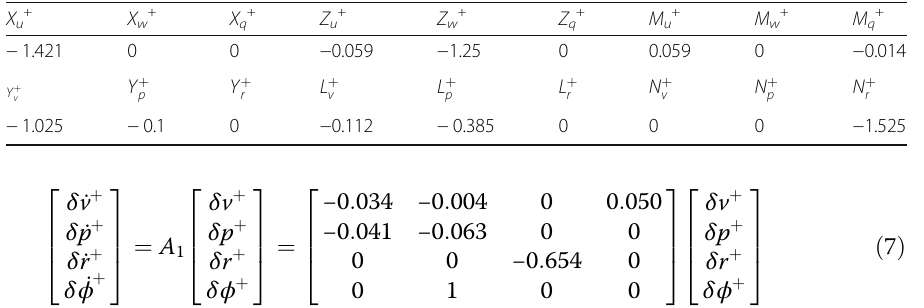
Table 6 Non-dimensional aerodynamic